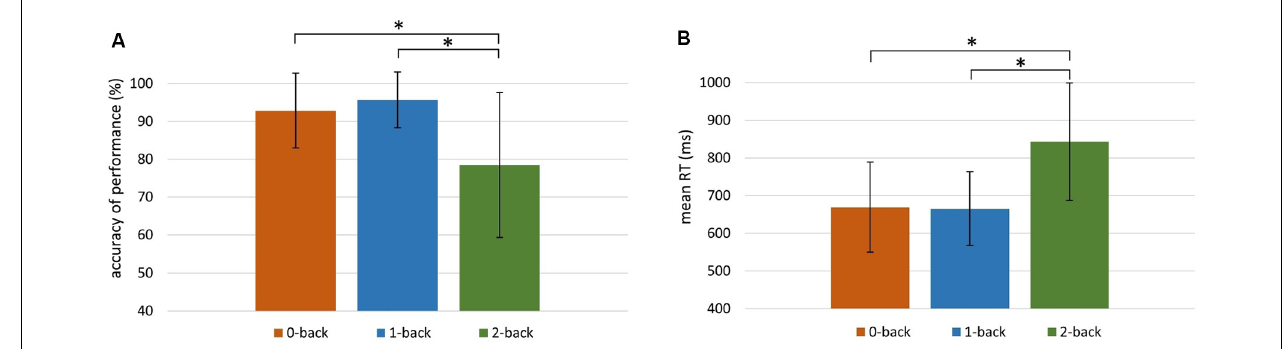
FIGURE 2 | Behavioral indices of working memory (WM) efficiency in the 0-, 1-, and 2-back conditions. (A) Accuracy of performance (%) in 0-back: M = 92.83, SD = 9.92; 1-back: M = 95.66, SD = 7.33; 2-back: M = 78.41, SD = 19.18. (B) Mean reaction time (RT) in 0-back: M = 669 ms, SD = 121 ms; 1-back: M = 665 ms, SD = 98 ms; 2-back: M = 843 ms, SD = 156 ms. Significant differences ( p < 0.001) are indicated with an